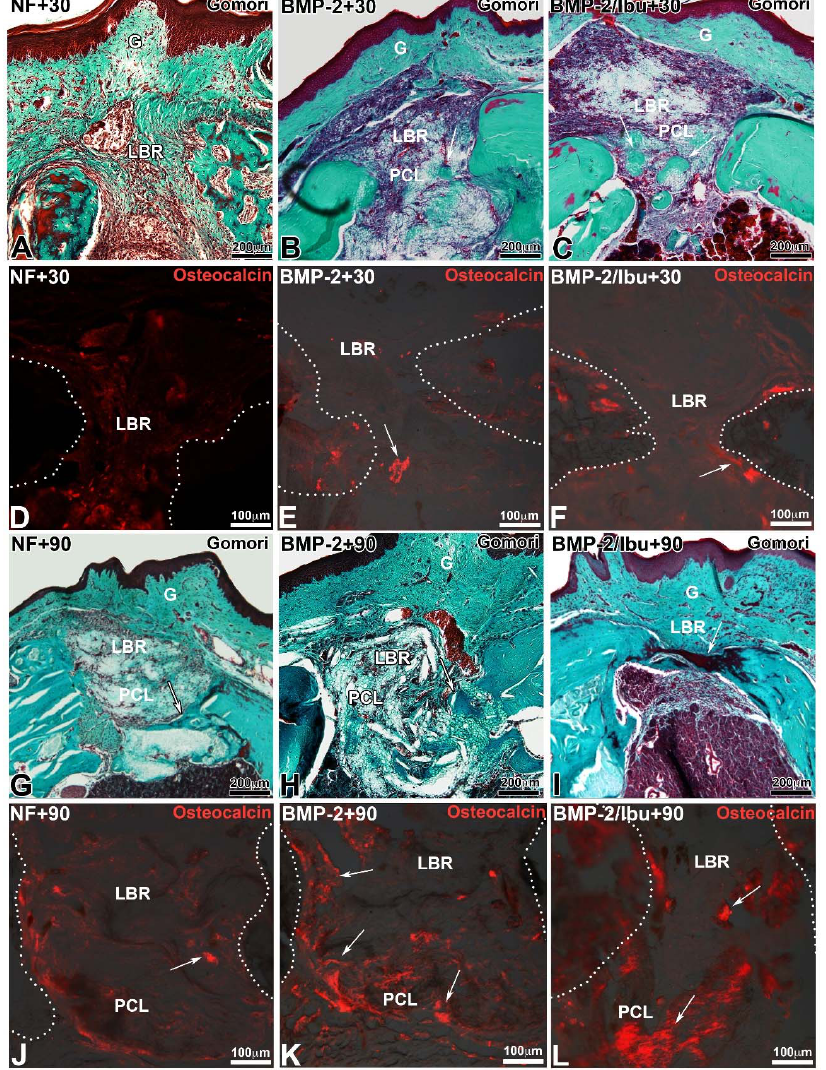
Figure 4. Trichrome of Gomori staining ( A – C , G – I ) and immunofluorescence for osteocalcin ( D – F , J – L ) after 30 ( A – F ) and 90 days ( G – L ) implantation of PCL ( A , D , G , J ), PCL/(BMP ‐ 2) 10 ( B , E , H , K ) and PCL/(BMP ‐ 2) 10 /(Ibu) 3 ( C , F , I , L ). Arrows indicated neoformed bone positive for osteocalcin. White dots indicate the limit of the maxillary bone. For the immunofluorescence, samples were embedded in Tissue ‐ Tek, frozen at − 20 °C and sectioned (10 μ m) using a cryostat (Leica, CM3000). Serial sections were rinsed with PBS, fixed for 10 min with 4% paraformaldehyde at 4 °C and treated as previously described [27] using the rabbit anti ‐ osteocalcin antibodies (Santa Cruz Biotechnology, dilution 1/200). Sections were observed with a fluorescence microscope (Leica DM4000B). G: gingiva, LBR: lesion with bone regeneration, PCL: scaffold.